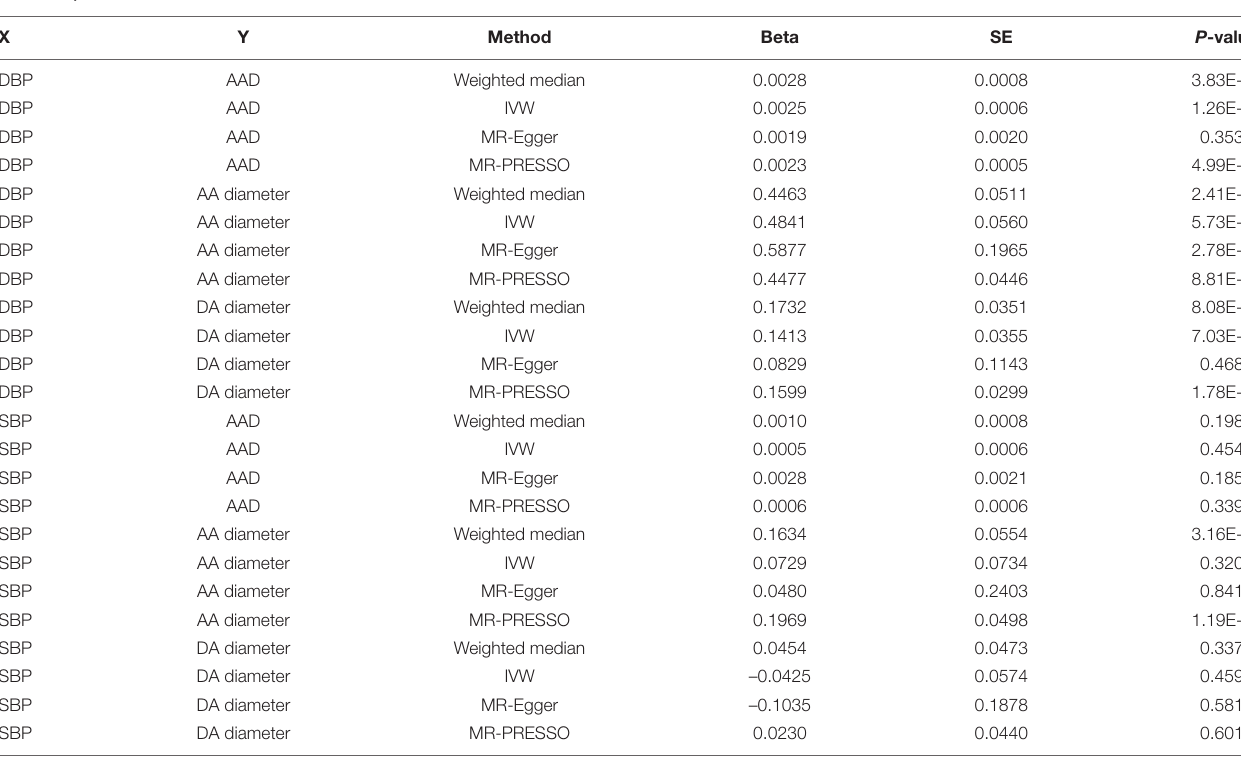
FIGURE 2 | Association between circulating cathepsin B and SBP. Effect-size estimates and variant-level contribution to CAUSE test statistics for circulating cathepsin B and SBP. TABLE 5 | The causation between BP and AAD and aortic